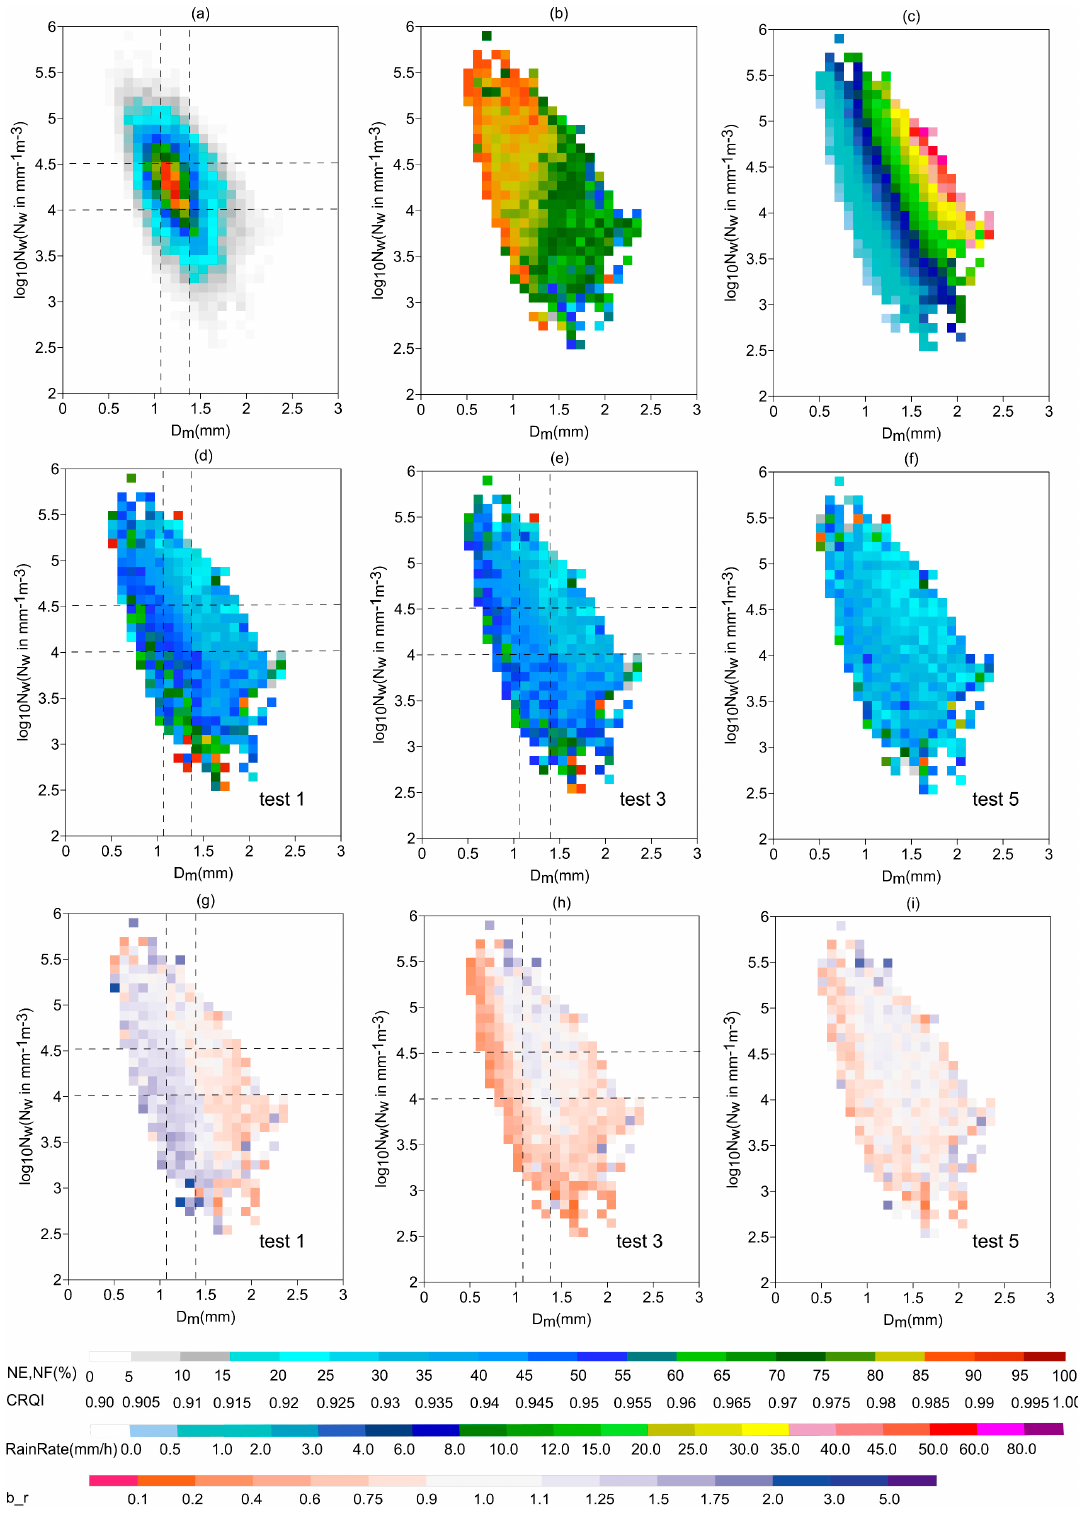
Figure 7. ( a ) Normalized occurrence frequency (NF) of log 10 N w versus D m . ( b ) CRQI of log 10 N w versus D m . ( c ) Hourly accumulated precipitation observed by RG stations of log 10 N w versus D m . ( d – f ) NE of log 10 N w versus D m for QPE in tests 1, 3, and 5. ( g – i ) B_rs of log 10 N w versus D m for QPE in tests 1, 3, and 5. D m and N w were derived from good-quality Z H and Z DR for all rainfall events. The dashed lines indicate data with high NF.